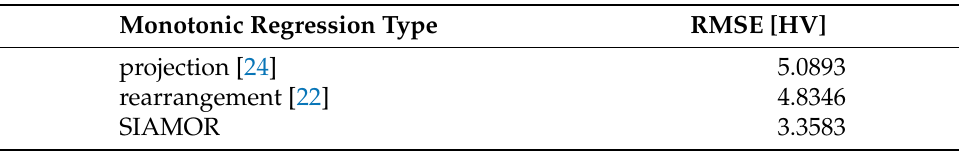
Table 4. Root-mean-squared deviations (RMSE) of the monotonic regression models from the training data for forming and press hardening of sheet metal (1D).